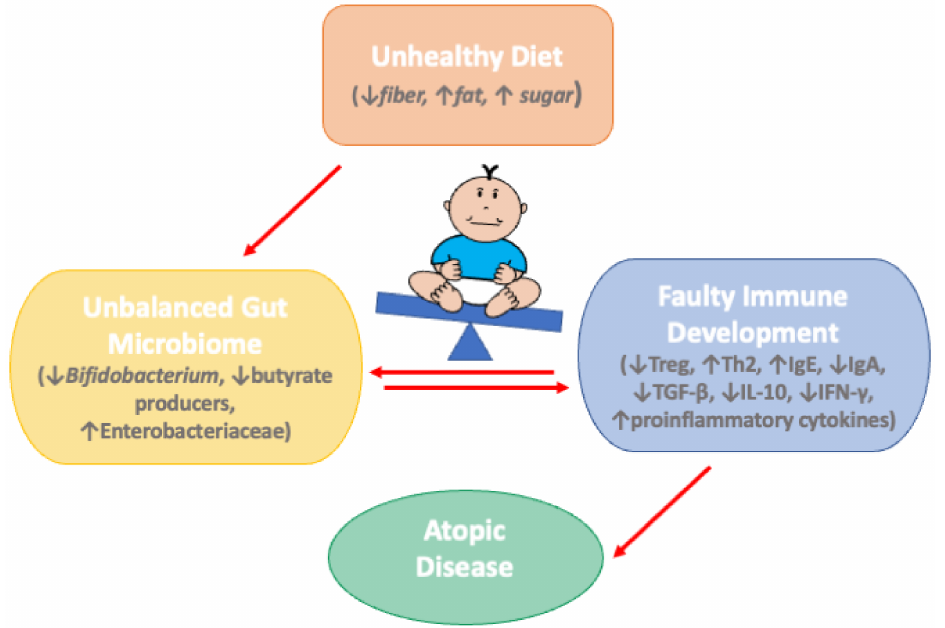
Figure 2. The effects of an unhealthy diet alter the development of the infant gut microbiota, resulting in faulty immune development and an increased risk of atopic